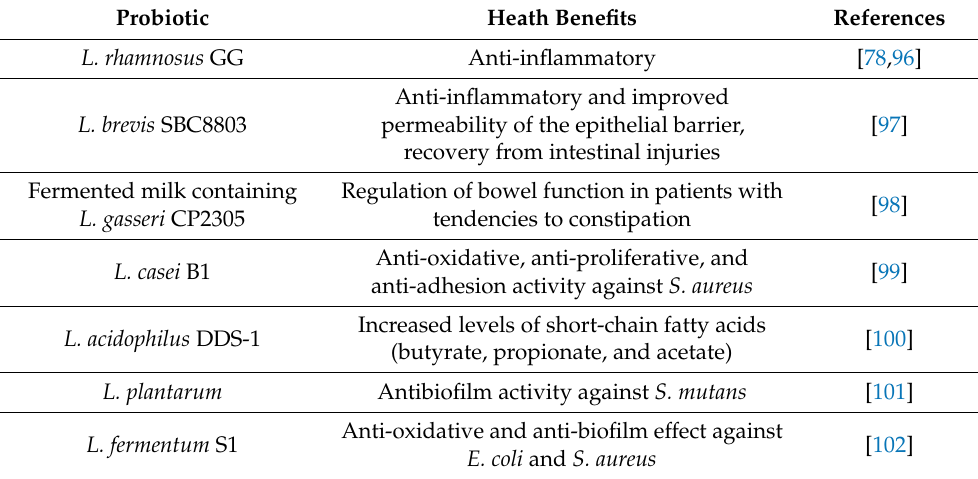
Table 2. Health benefits of paraprobiotics and